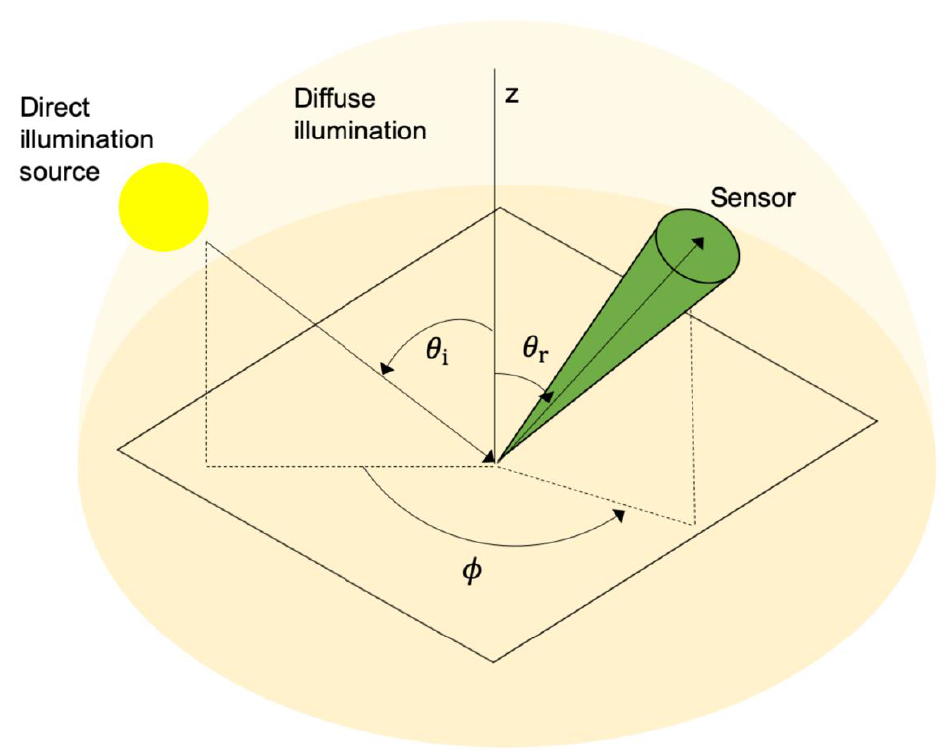
Figure 8. Diagram of the incident and reflected viewing angles for a directional light source with direct and diffuse (hemispherical) incoming radiance and conical reflected radiance, corresponding to the hemispherical-conical reflectance factor (HCRF) described by Schaepman-Strub et al. [259]. The incident viewing angle ( θ i ), reflected viewing angle ( θ r ), and the azimuth angle ( φ r ) together define the angular coordinates of both the directional illumination and the light reflected toward the sensor, with respect to the surface normal, z.